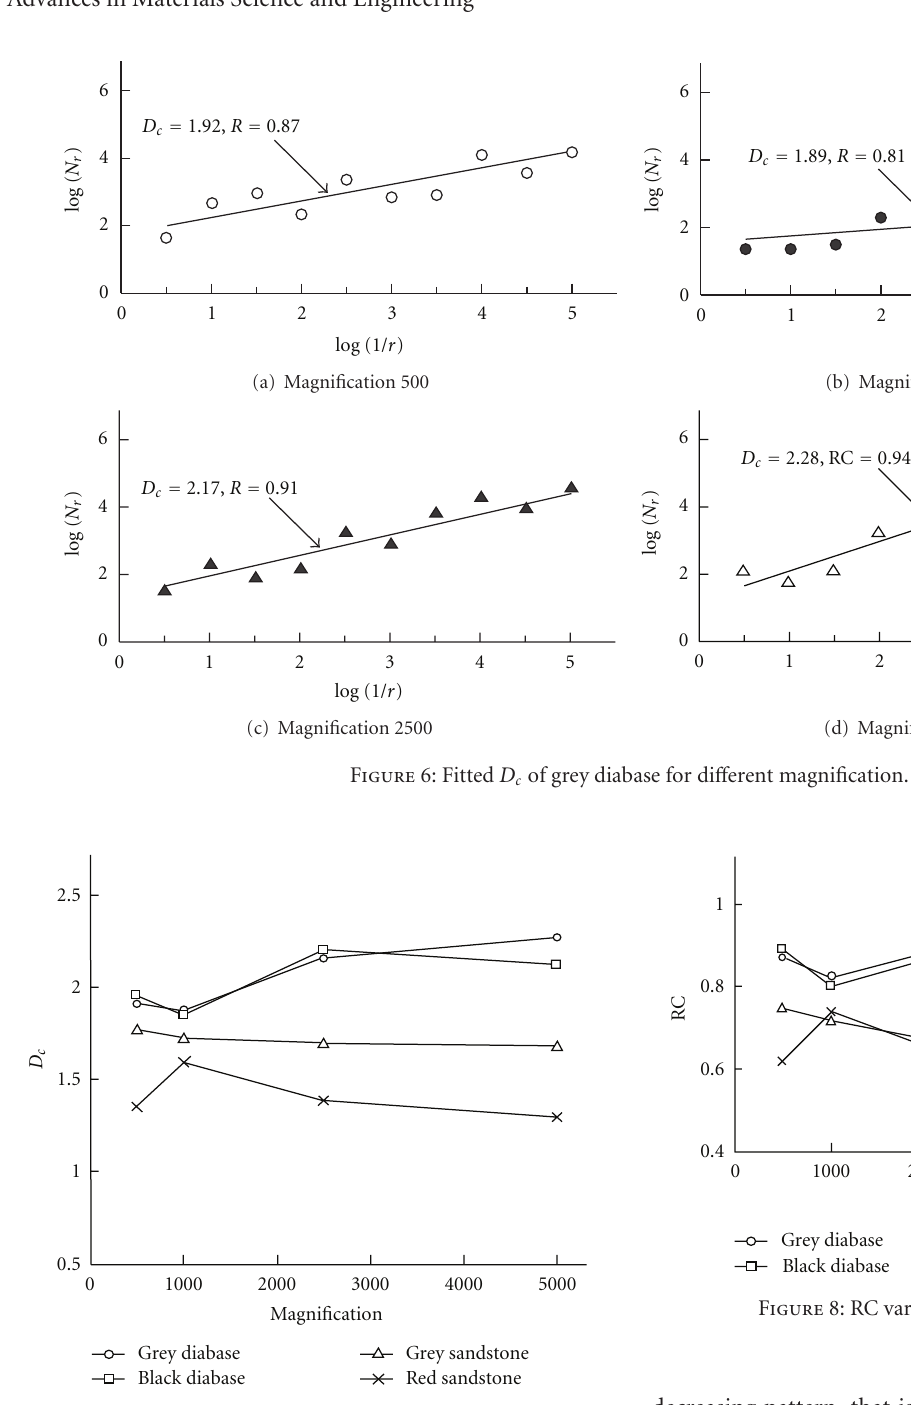
Figure 7: D c variation with magnification.